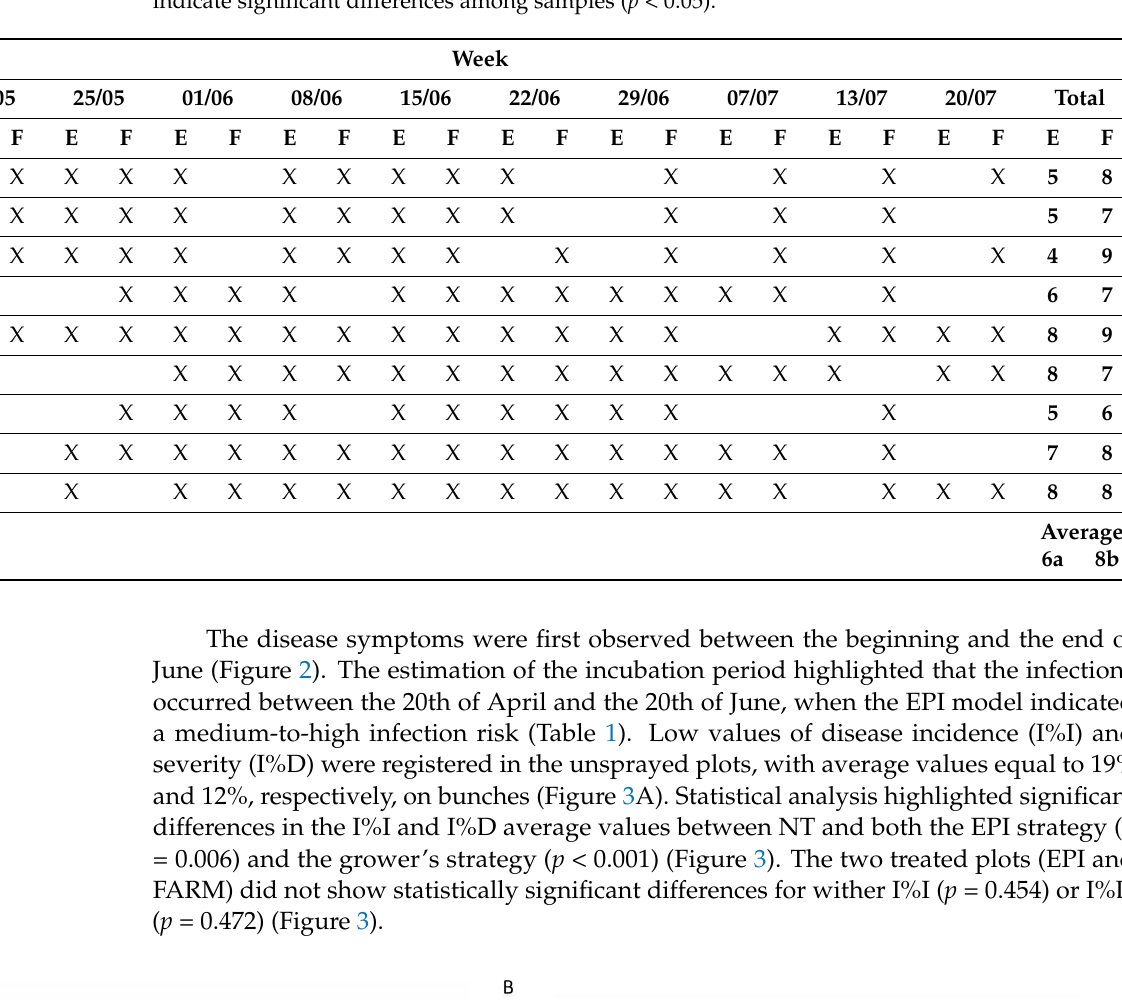
( p = 0.472) (Figure 3).